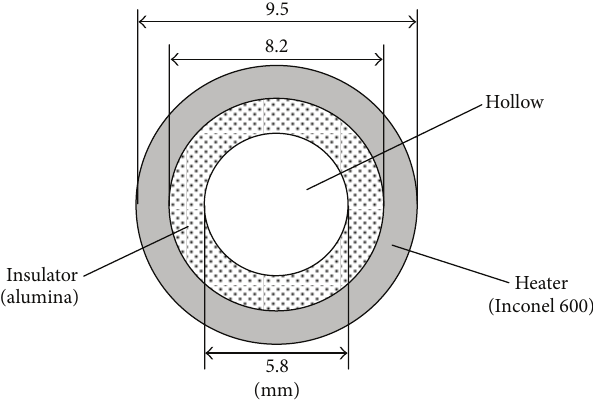
Figure 10: Cross-sectional View of Heater Rod. Table 5: Cosine axial power